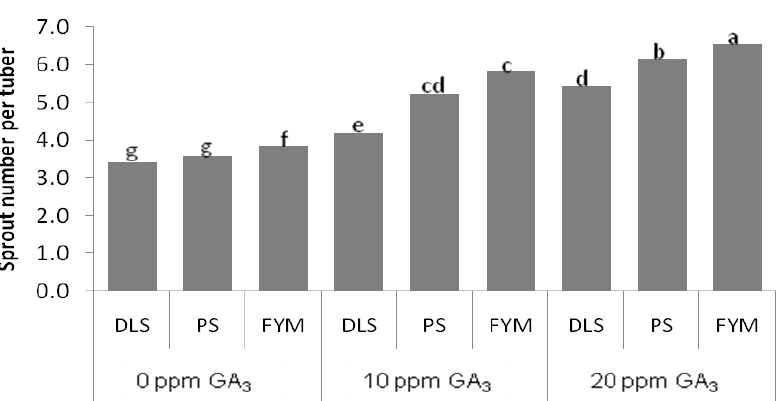
and storage methods on number of sprouts per tuber of two potato varieties grown in Figure 1: Effects of seed tuber treatment with GA 3 Ethiopia, Bars with the same letter(s) are not significantly different from each other at 0.05 probability level, DLS-Diffused light store, PS-Pit store, FYM-Farm-yard